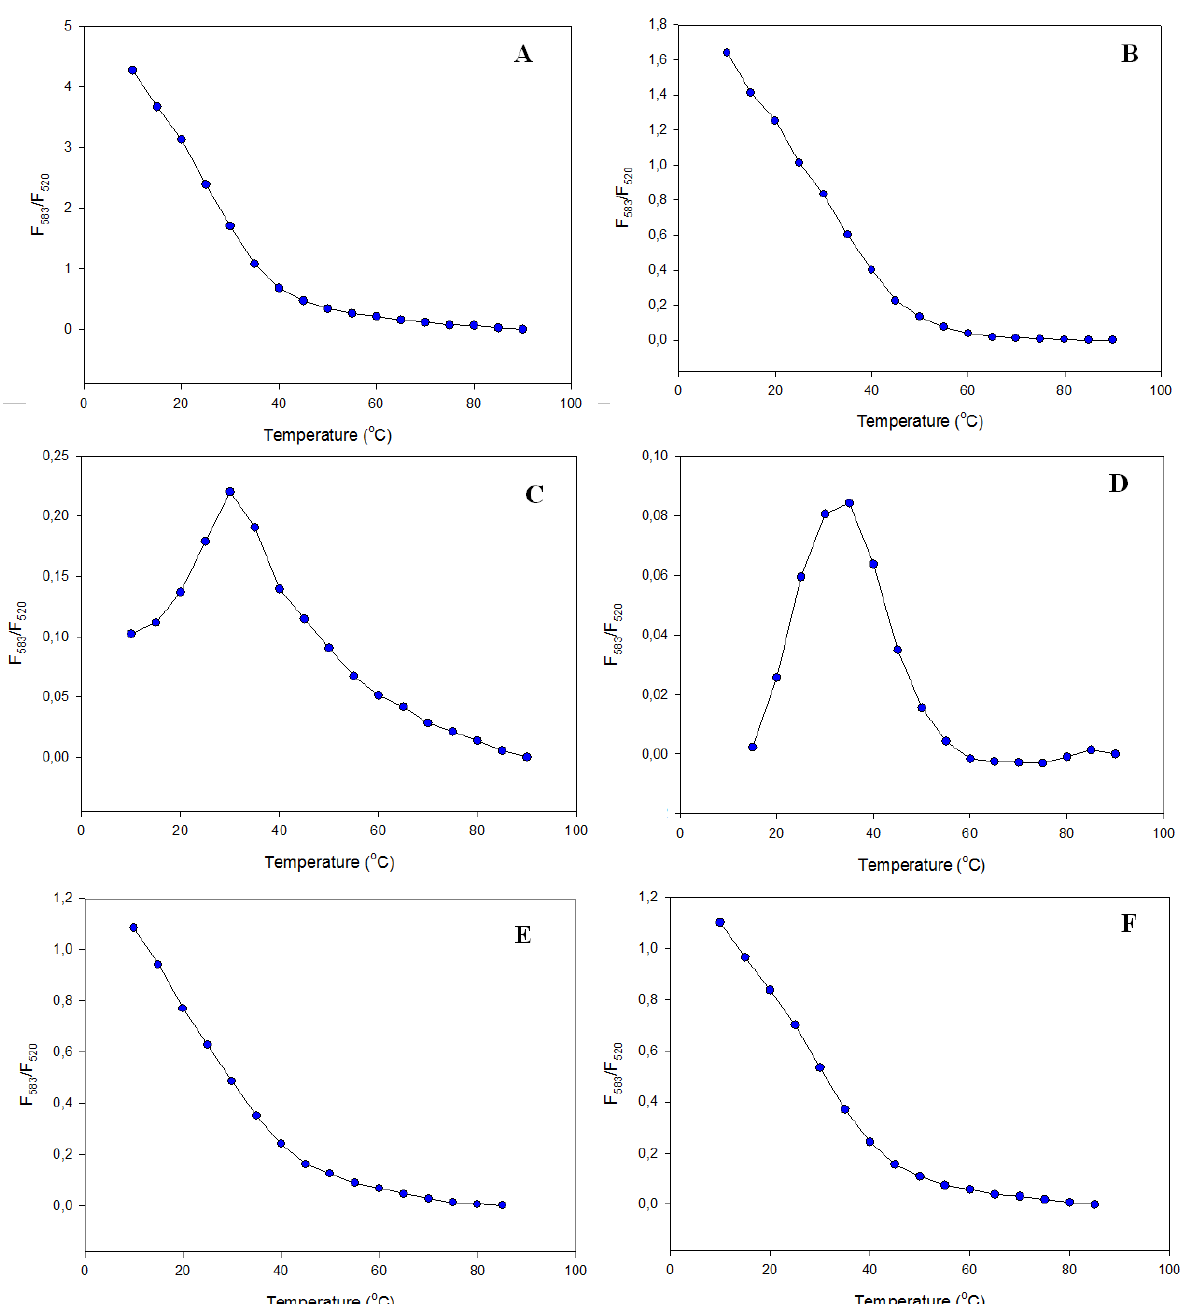
Figure 6. The dependence of fluorescence intensity ratio (F 583 /F 520 ) vs. temperature for ( A ) F19T, ( B ) ChF19T, ( C ) 16F19T, ( D ) Ch16F19T, ( E ) 16F19T/Ch16’, and ( F ) Ch16F19T/Ch16’ probes. Conditions: 0.2 μM strand concentrations, 10 mM cacodylate buffer (pH 7.5), 100 mM KCl, λ ex = 490